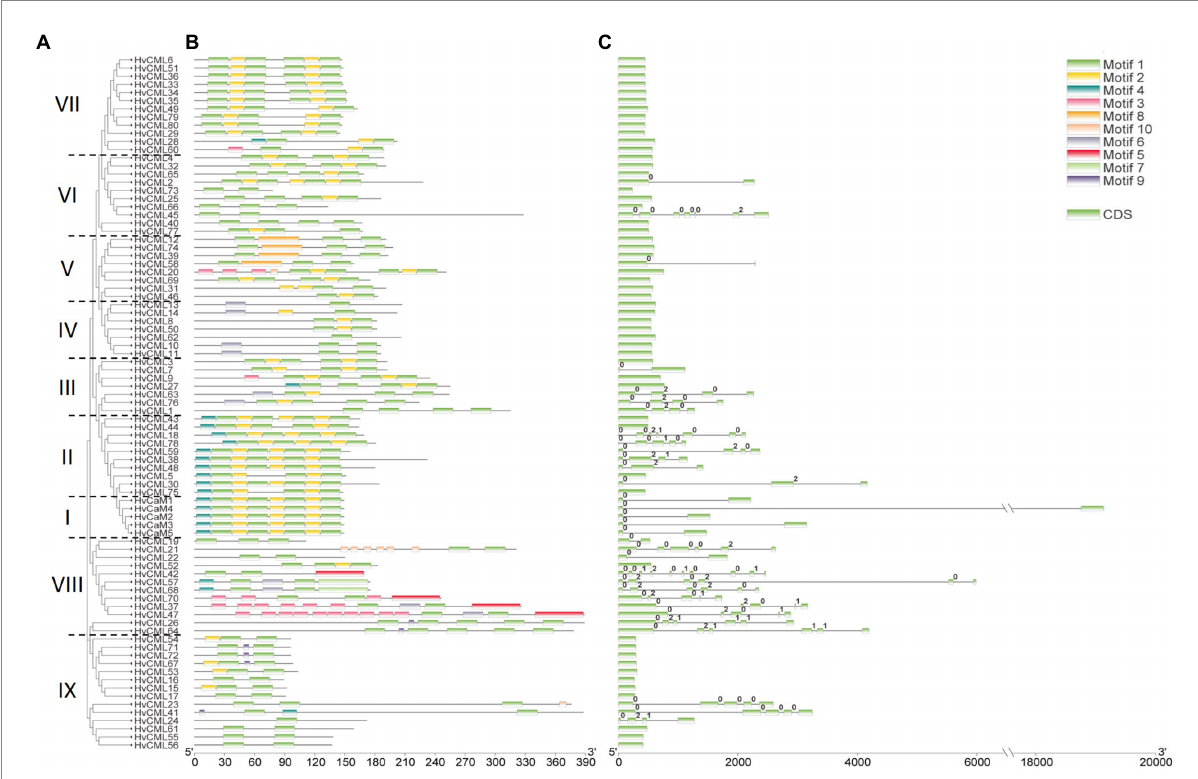
FIGURE 2 Phylogenetic relationship and sequence characteristics of HvCaMs/CMLs . (A) Phylogenetic tree of HvCaM/CML proteins; (B) Conserved motifs of HvCaM/CML proteins; (C) Gene structure of HvCaMs/CMLs